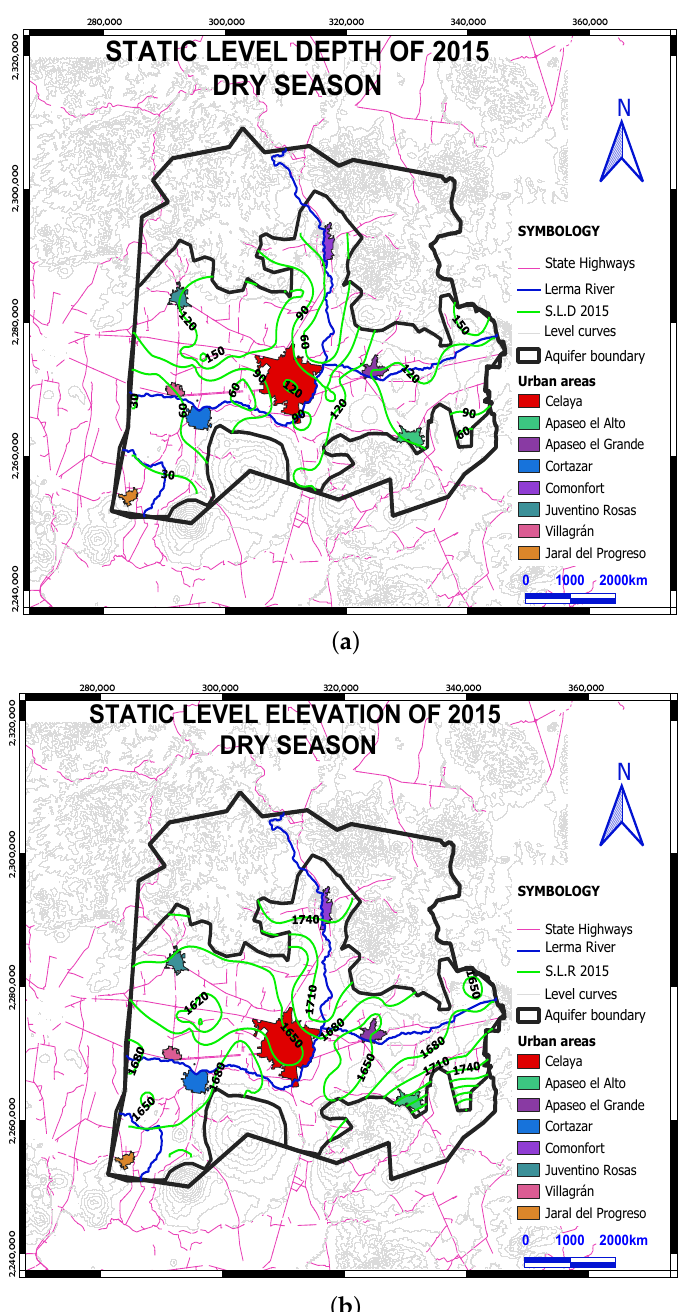
Figura 1.12: Temporada de Secas: Elevaci´on del nivel est´atico en el a˜no 2019. Figure 4. Dry season of 2015. ( a ) Distribution of static level depth lines. ( b ) Distribution of static level elevation